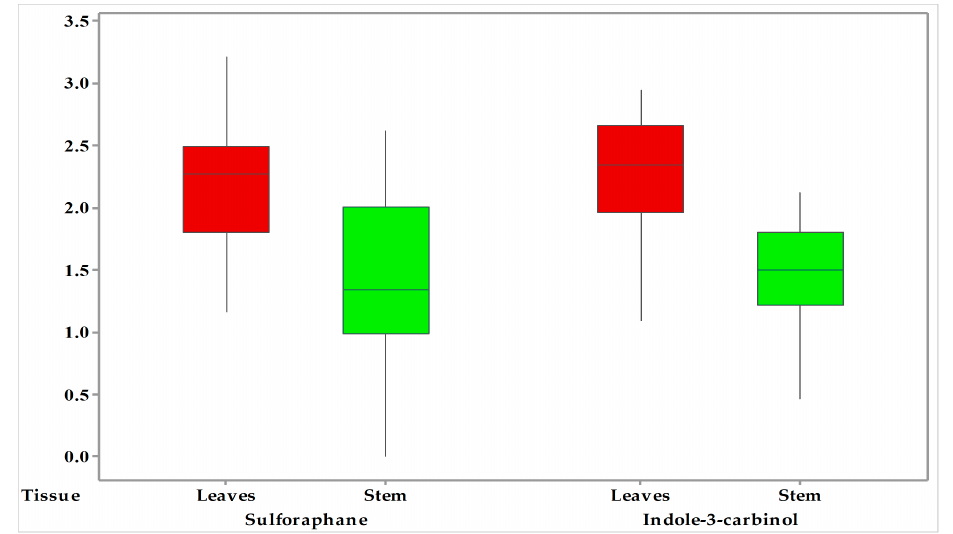
Figure 5. Box plot of sulforaphane and indole-3-carbinol concentration in the leaves and stems of rapeseed samples.